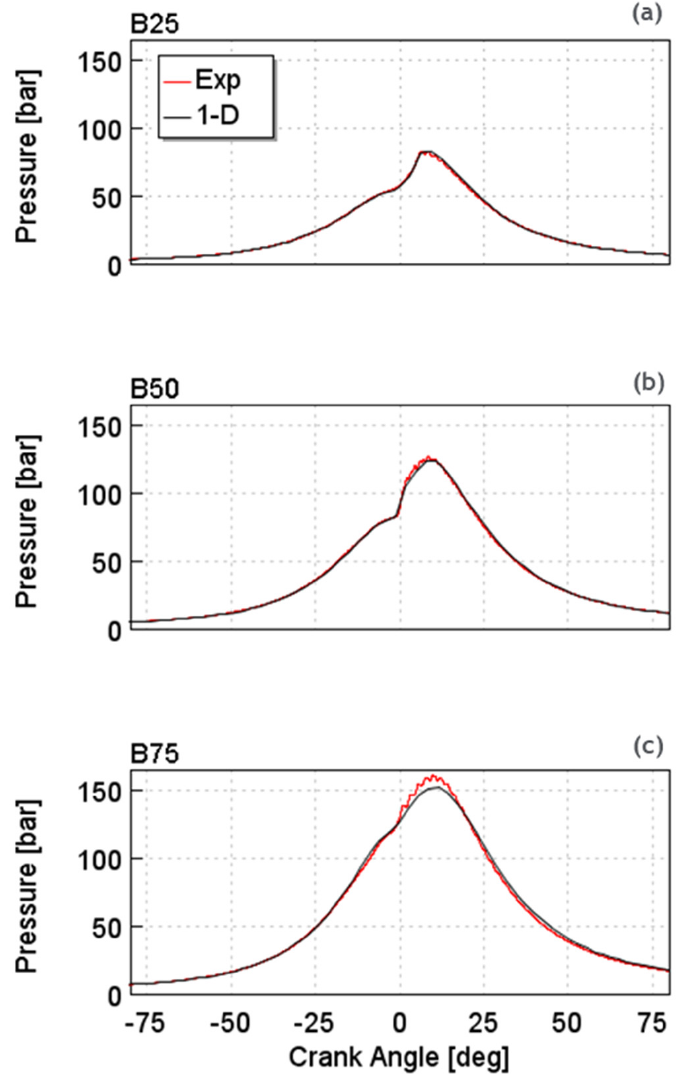
Figure 3. Experiments versus 1-D engine model predictions for closed-cycle in-cylinder pressure at ( a ) B25, ( b ) B50, and ( c ) B75, using RON93 gasoline at CR 15.7.